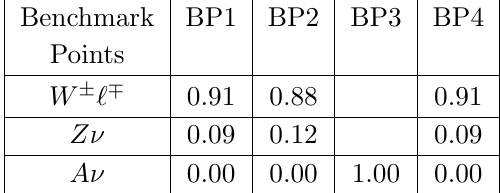
Table 5 . Branching fraction for N i for the benchmark points for collider study at the LHC. Here ‘ (cid:7) spans over all three charged leptons namely, e; (cid:22); (cid:28) depending on the choice of N i